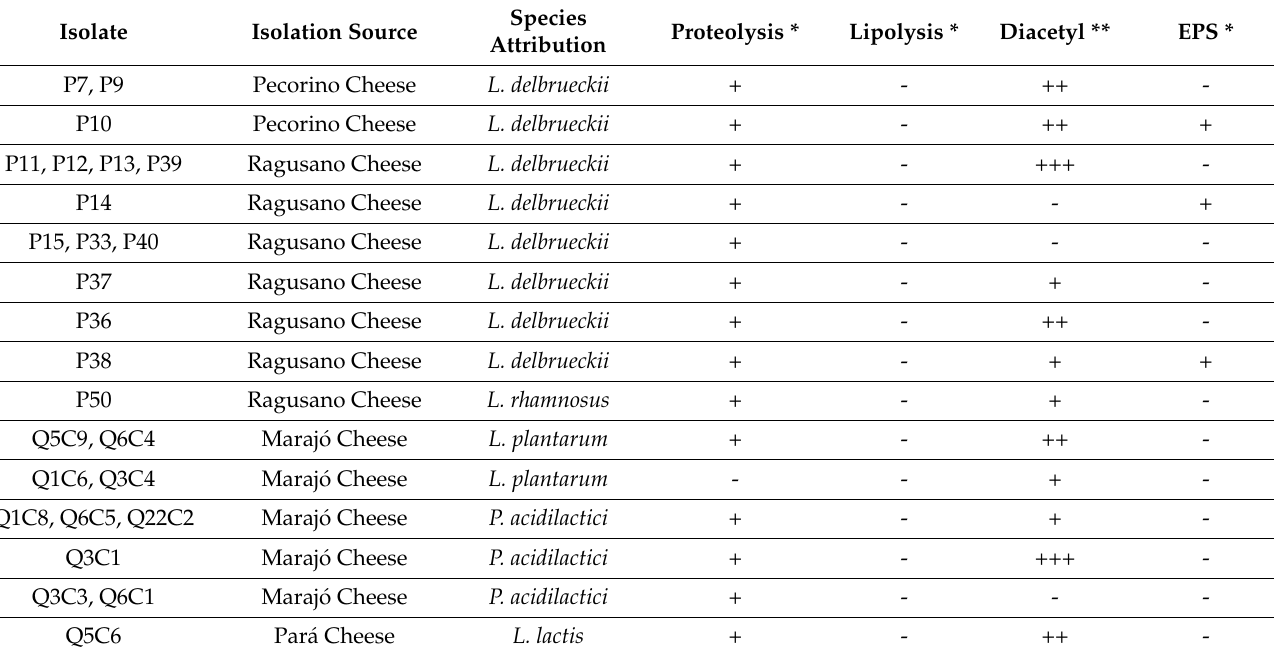
Table 1. Identification and technological properties of strains isolated from Pecorino cheese, Ragusano cheese, Maraj ó cheese and Par á